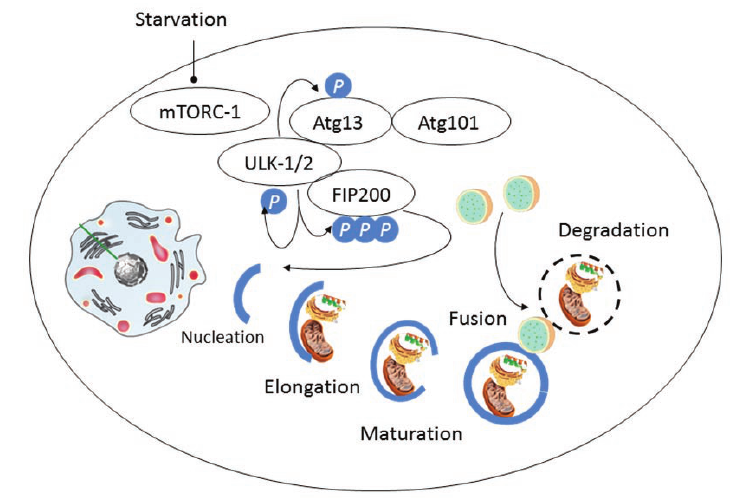
Figure 1. Autophagy is activated by by a condition of starvation (Modified from Liang C, 2010; Chen Y, et al. 2011; Mehrpour M, et al.